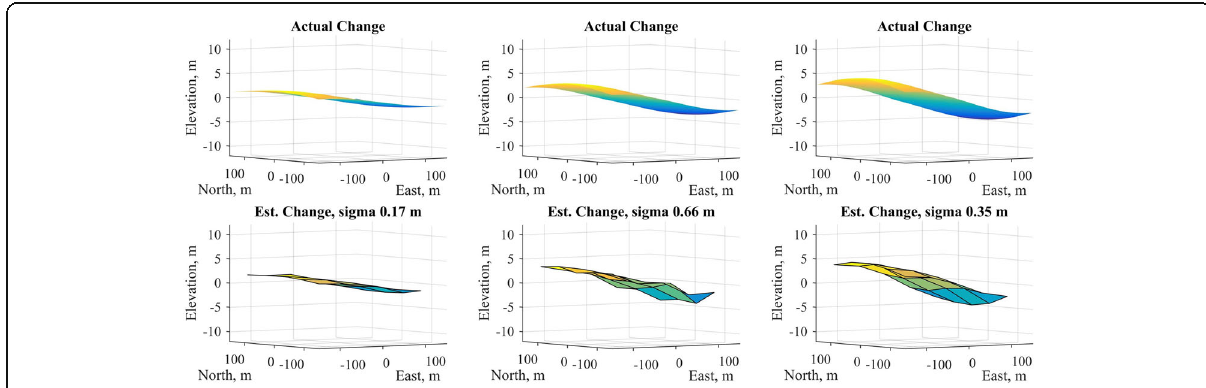
Fig. 9 Actual vs. estimated terrain change in year 7 ( left ), year 19 ( middle ) and year 31 ( right ). Upper: actual terrain change x ref ; lower: estimation in states